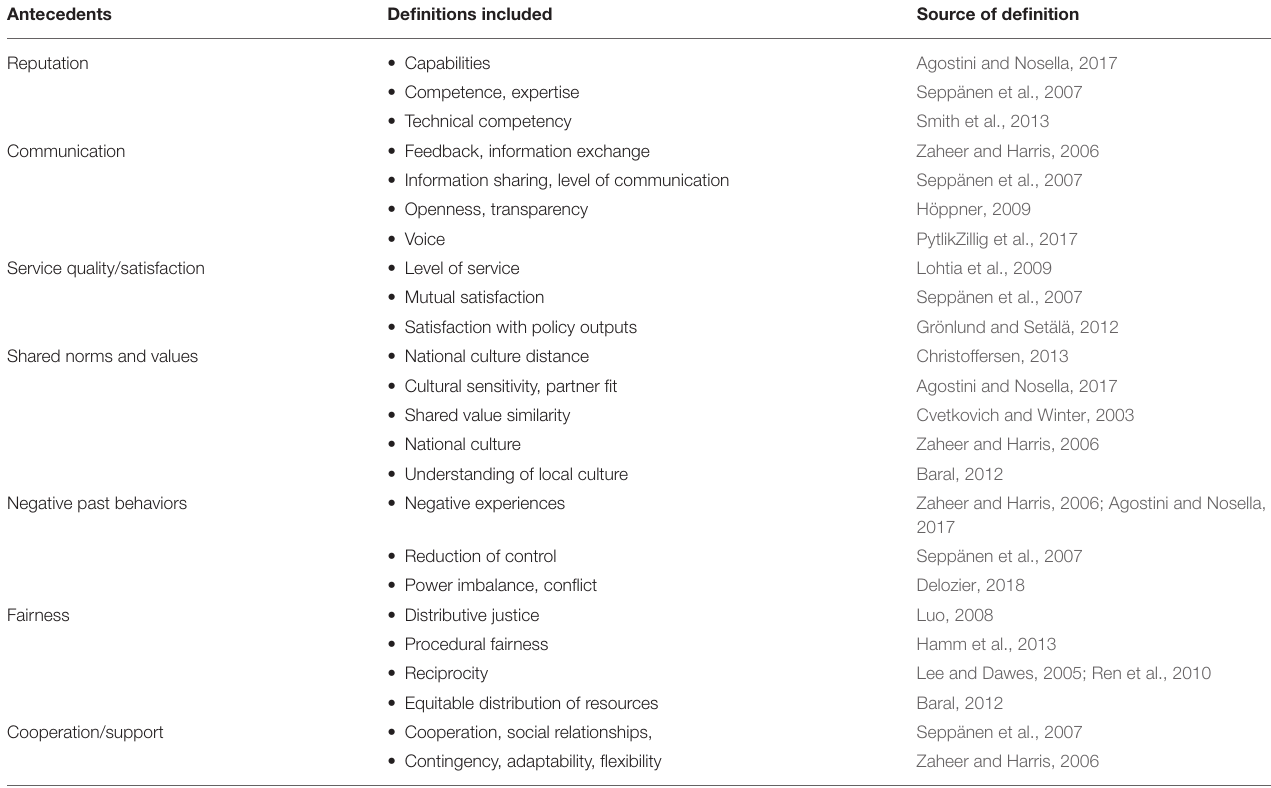
TABLE 1 | Integrated framework of antecedents of